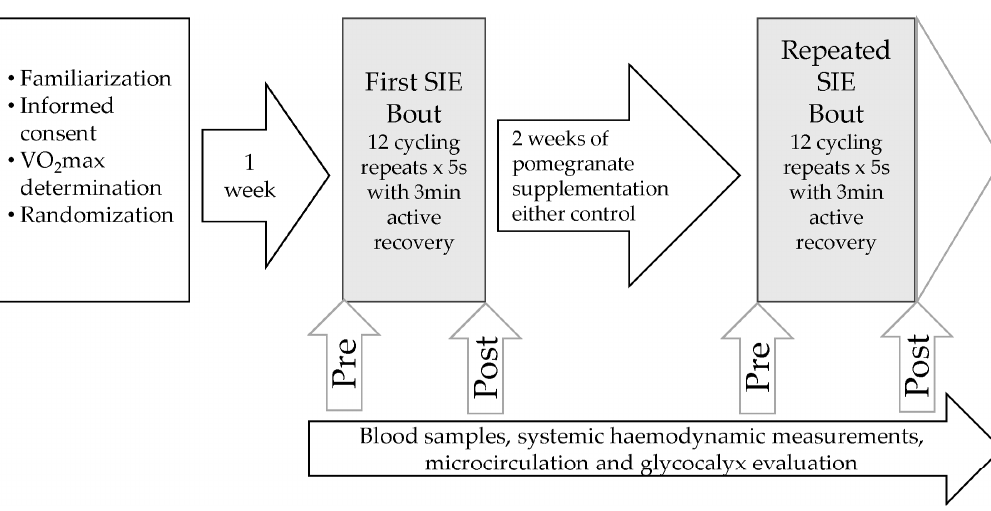
Figure 1. Experimental